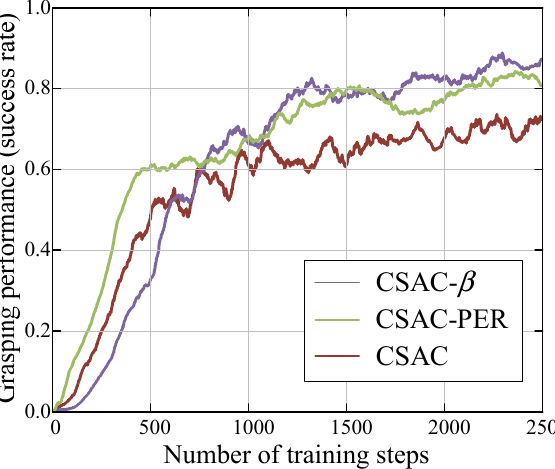
Figure 7. Grasping performance of different sampling algorithms.